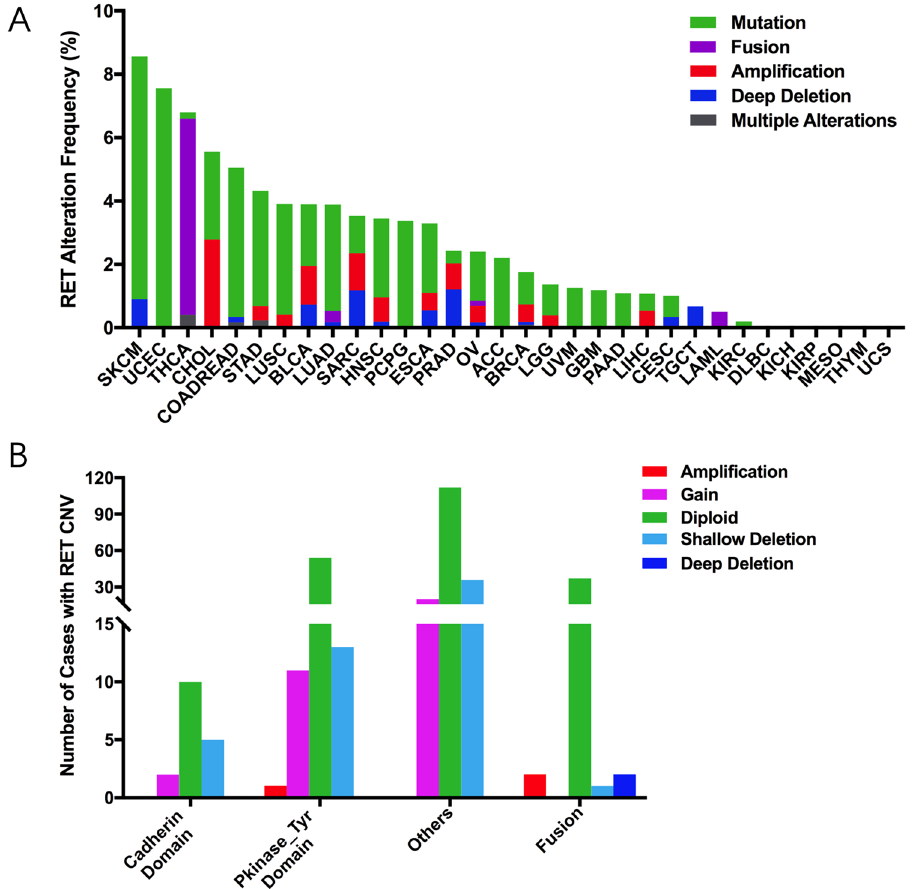
Figure 6. The frequency and distribution of RET alterations in TCGA cancers. ( A ) The frequency of combined RET alterations including mutations and CNVs among 32 TCGA cancers. ( B ) The distribution of RET CNVs in combination with RET mutations in diverse RET functional